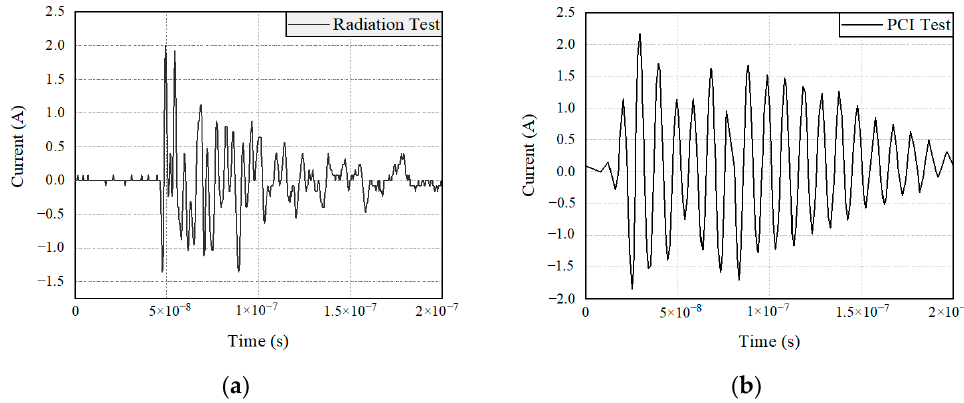
Figure 12. Power port signal: ( a ) In the radiation; ( b ) In current injection tests.